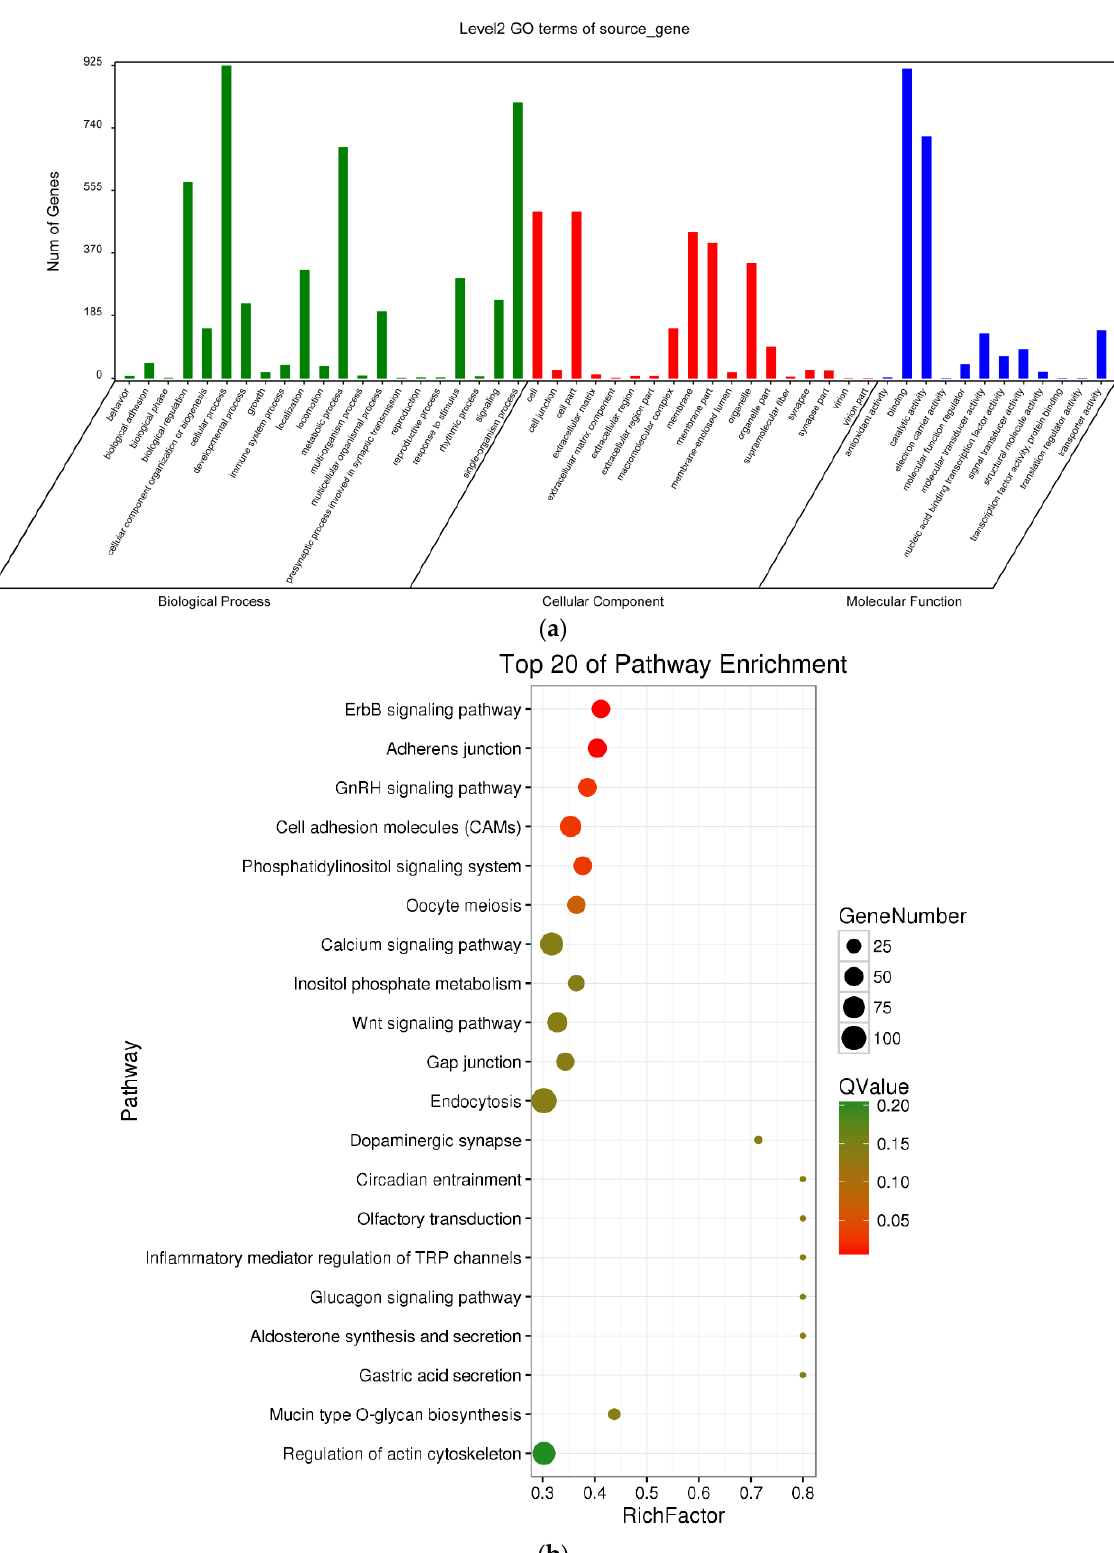
Figure 4. GO and KEGG pathways analyses. GO ( a ) and the top 20 KEGG ( b ) enrichment analyses of parental genes producing differentially expressed circRNAs.